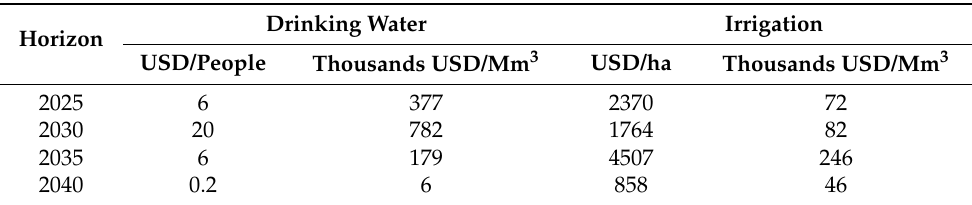
Table 6. Cost-effectiveness indicators of the agreed plan for water supply actions for drinking water and